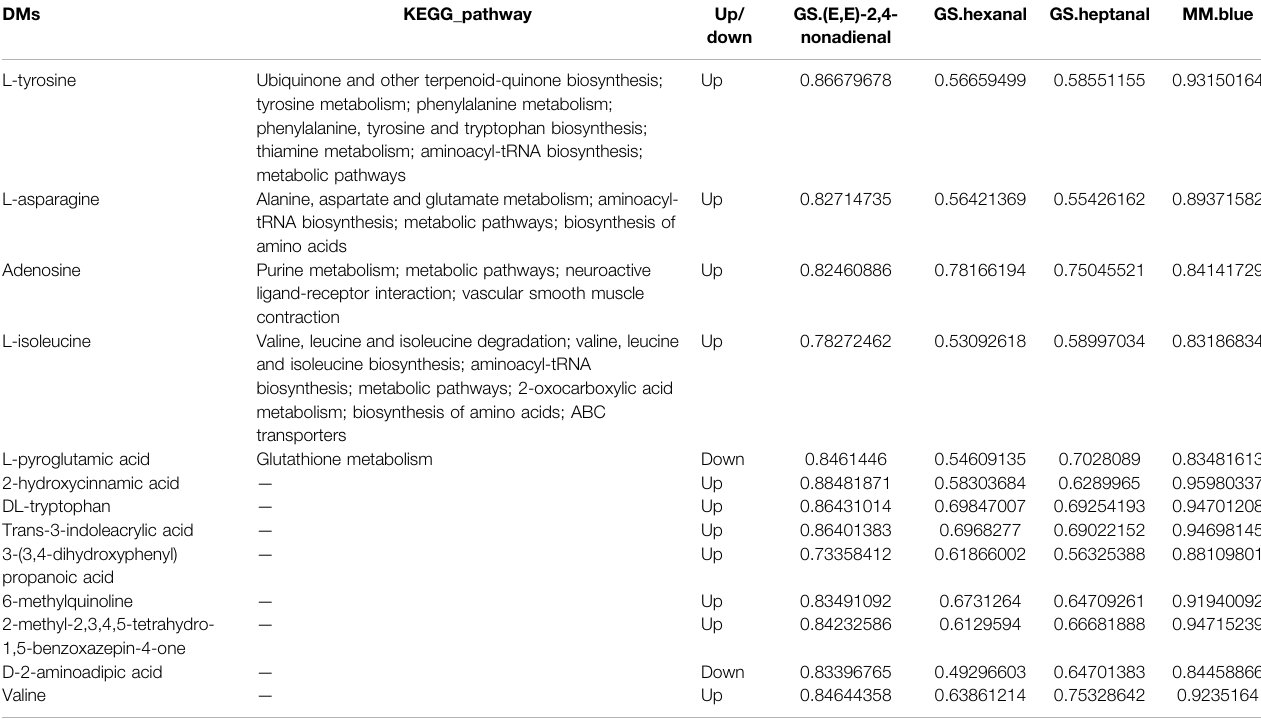
TABLE 1 | Common DMs related to heptanal and (E,E)-2, 4-nonadienal in the blue module of BM